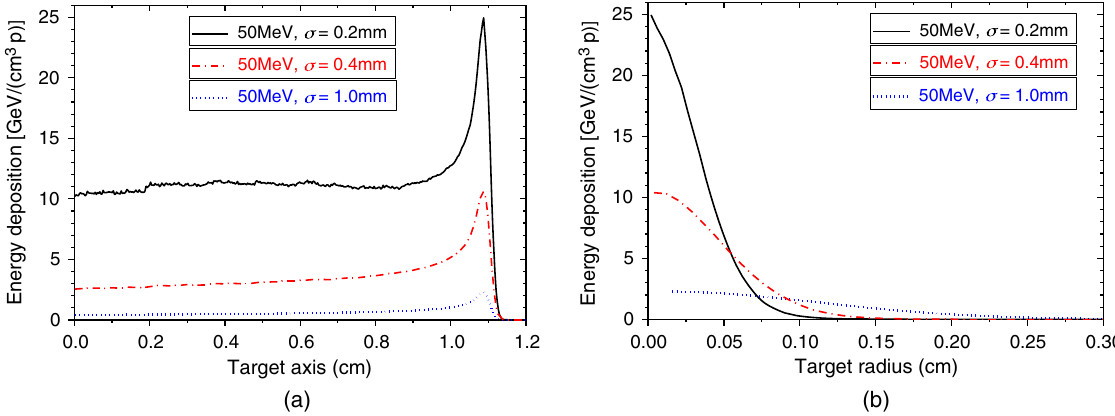
FIG. 12. Energy deposition per 50 MeV proton in a cylindrical graphite target for three different beam sizes of 0.2, 0.4, and 1.0 mm (a) in the longitudinal direction at r ¼ 0 and (b) in the radial direction at L ¼ 1 . 09 cm (position of the Bragg